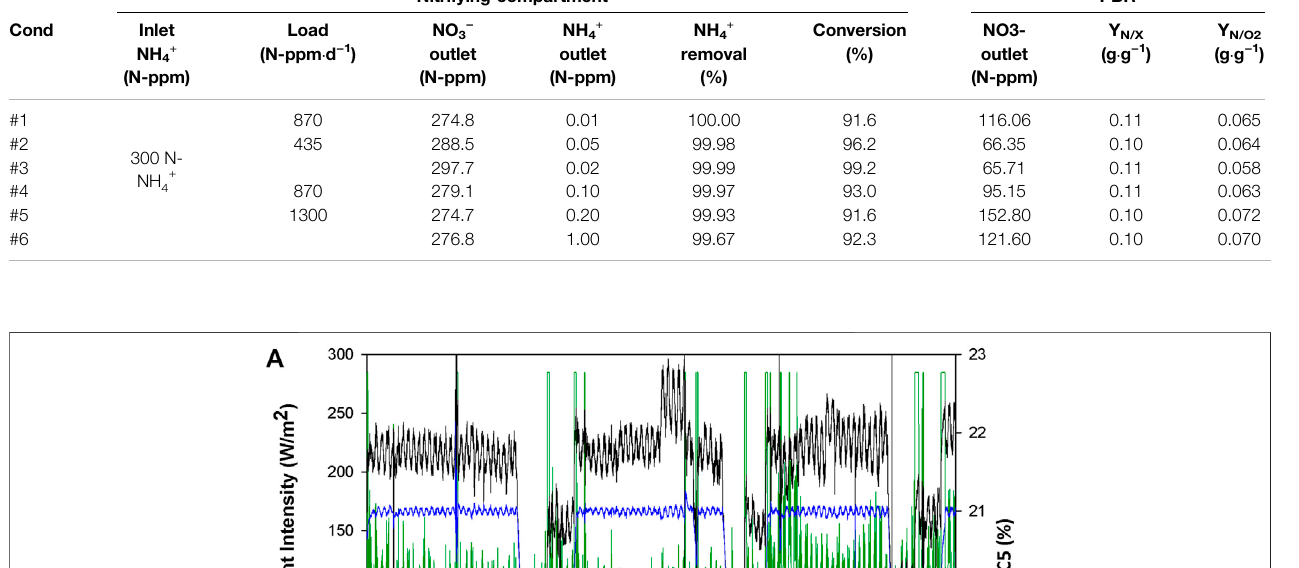
TABLE 2 | Nitrogen balances observed in nitrifying bioreactor for every experimental condition during liquid connection experiments between nitrifying and photosynthetic compartment. The outlet of NO 3 − from nitrifying bioreactor is considered as the inlet concentration in the PBR. Nitrifying compartment PBR